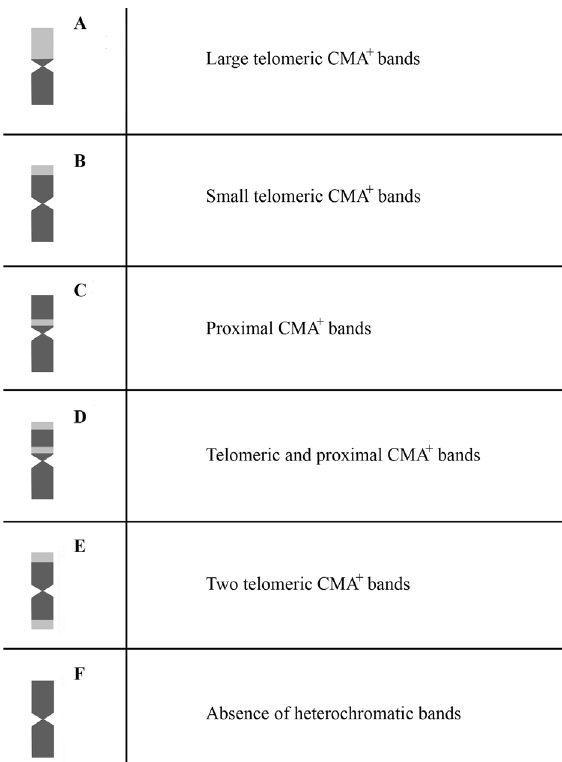
Figure 3 - Main chromosome types in Bignonieae (Bignoniaceae) according to the sizes and positions of the CMA +